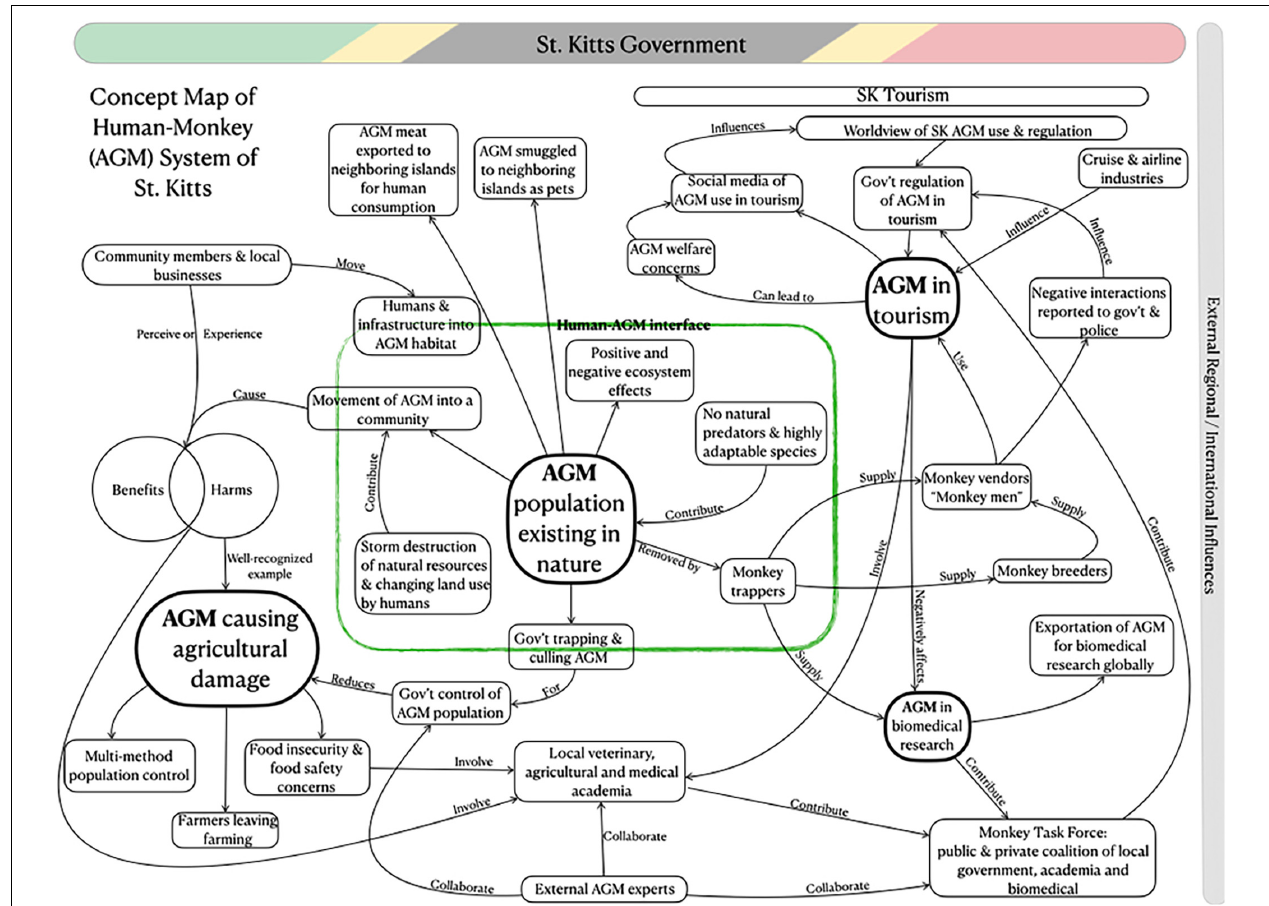
FIGURE 2 | Concept map of the human–monkey (AGM) system of St.